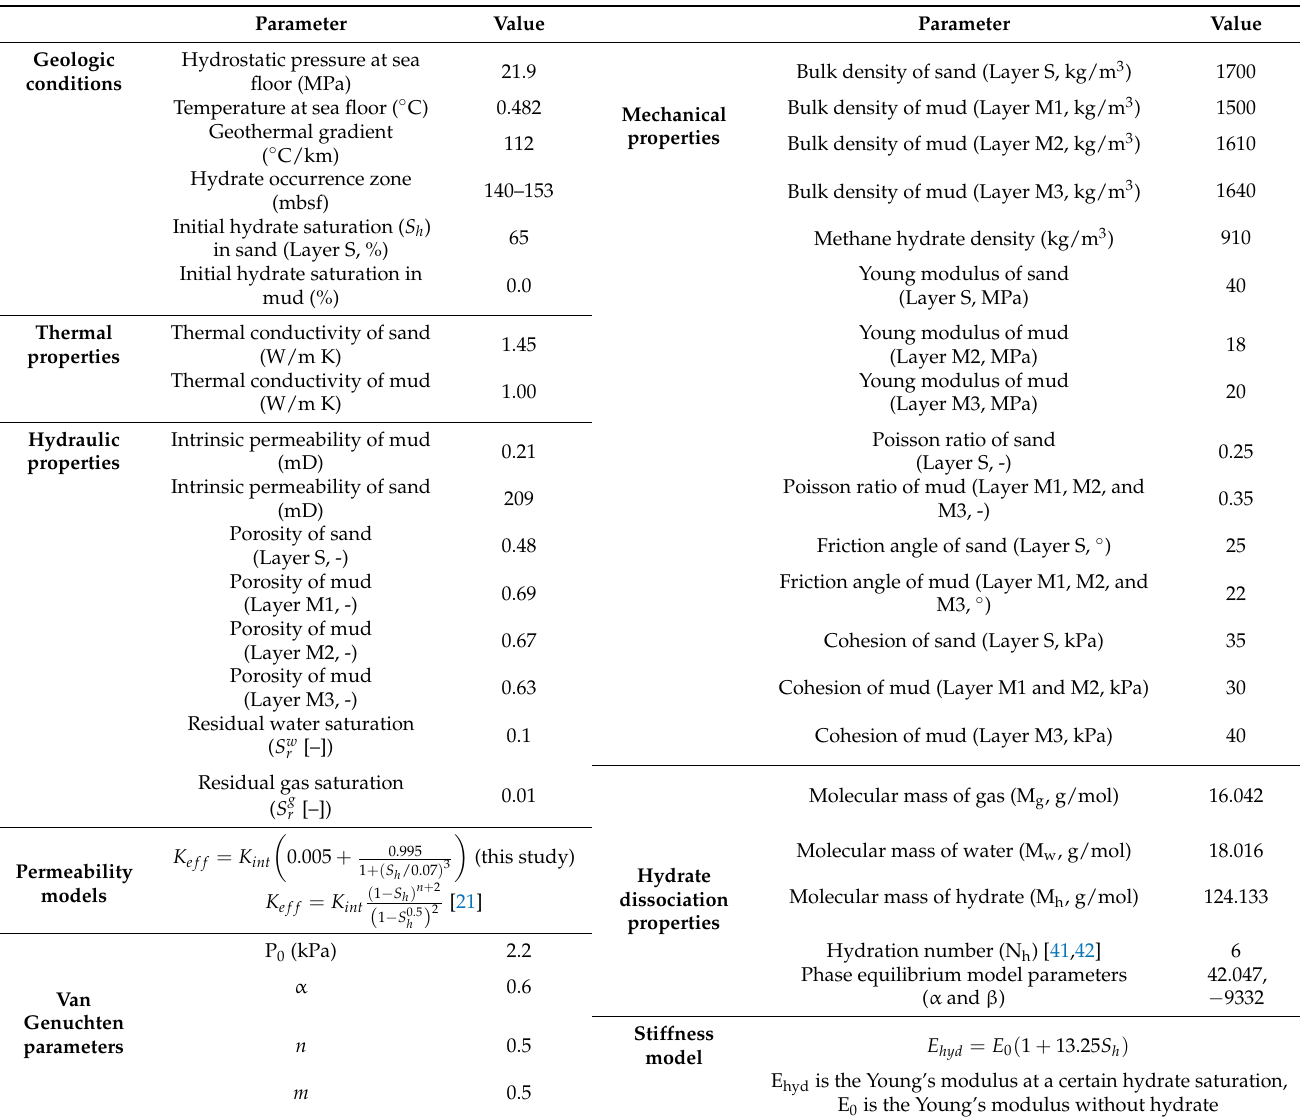
Figure 7. UBGH2-6 geometry used for numerical simulation (modified from [35]). Table 3. Basic thermal, hydraulic, and mechanical input properties